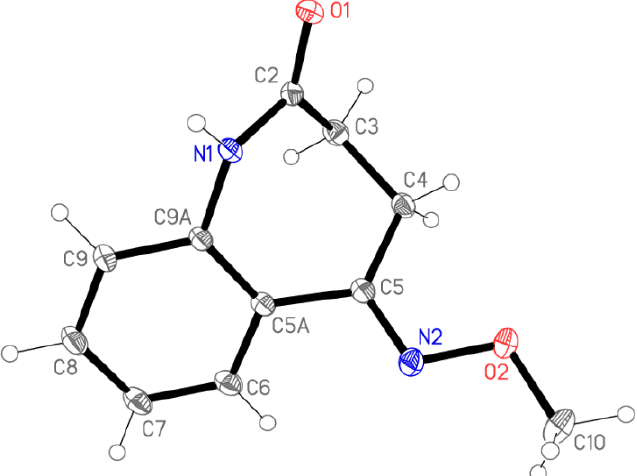
Figure 1. The structure of compound 4 in the crystal. Ellipsoids represent 50% probability levels. Selected bond lengths [Å], bond angles and torsion angles [°]: N(2)-C(5) 1.2903(10), N(2)-O(2) 1.4133(8), C(4)-C(5) 1.5058(10), C(5)-C(5A) 1.4845(10), C(10)-O(2) 1.4315(10), C(5)-N(2)-O(2) 110.56(6),